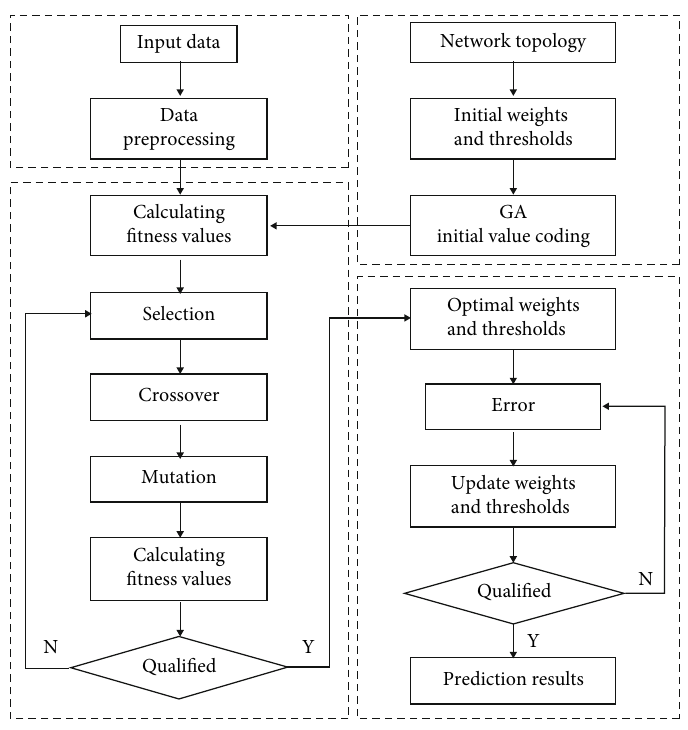
Figure 6: GA-BP neural network algorithm fl